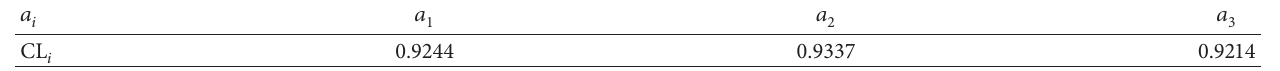
i of all experts on emergency